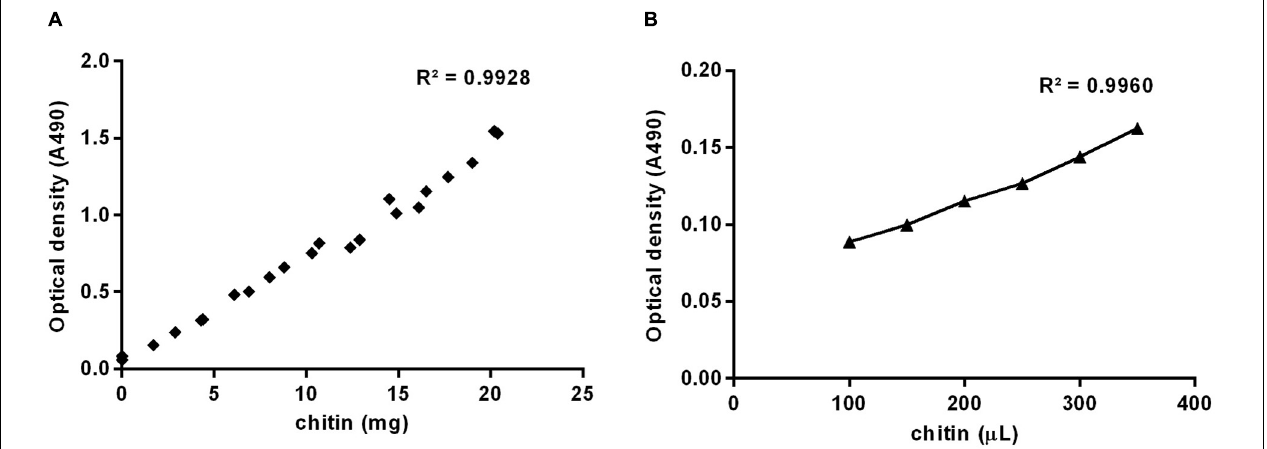
FIGURE 1 | Standard curves prepared using increasing masses of powdered chitin from shrimp shells (A) or increasing volumes of colloidal chitin suspension (B) , based on optical density at 490 nm.